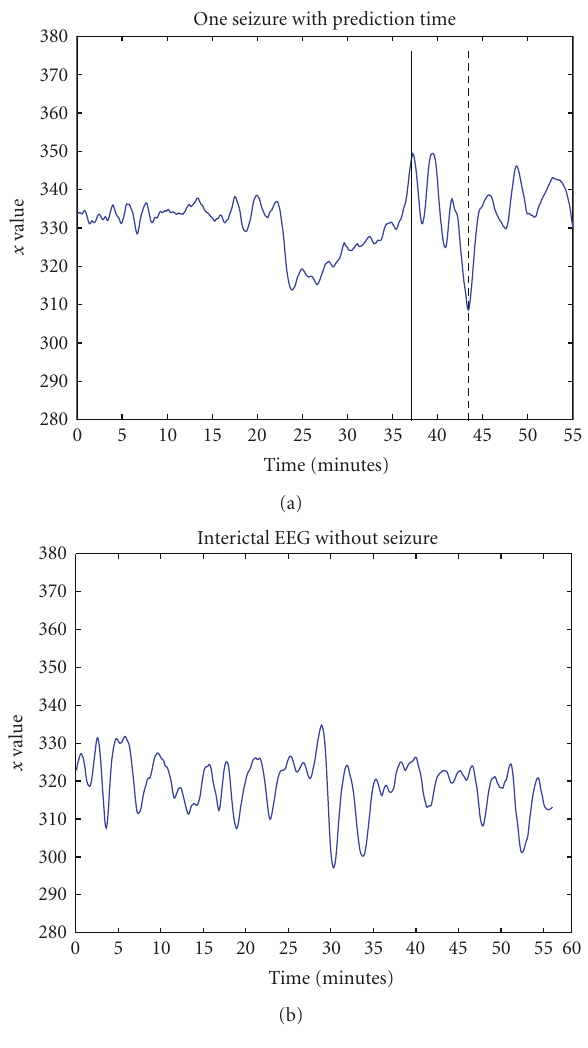
Figure 7: Ictal and interictal hidden variable x from one patient with epilepsy. The vertical solid line marks prediction time point and the vertical dashed line indicates seizure